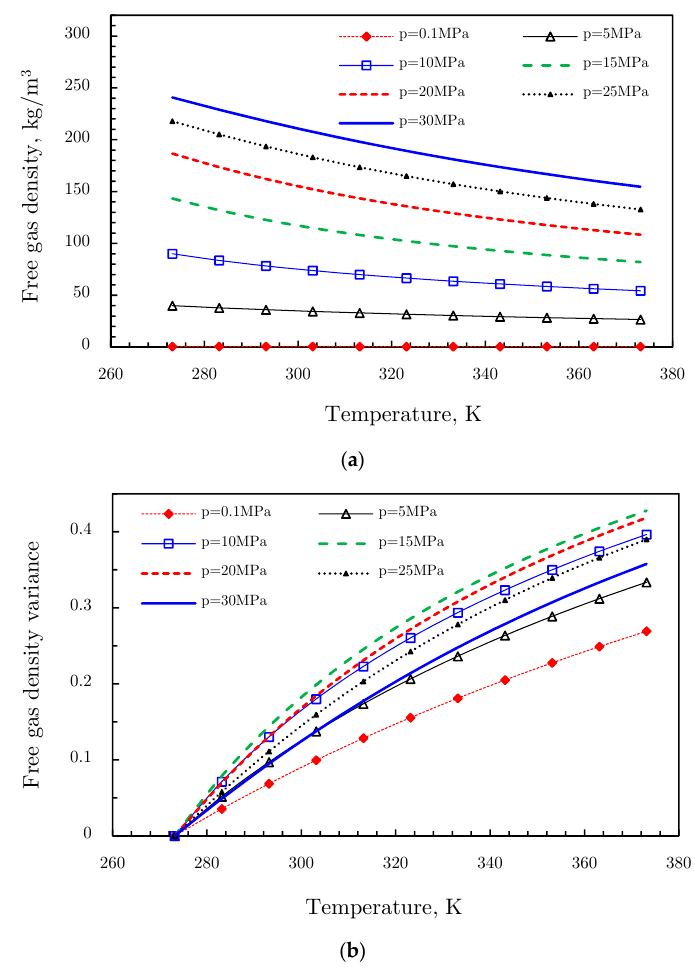
Figure 27. Free gas density ( a ) as well as its variance ( b ) in different pressure and temperature conditions. (2) Measured by experiments: Bulk phase gas density can also by measured by